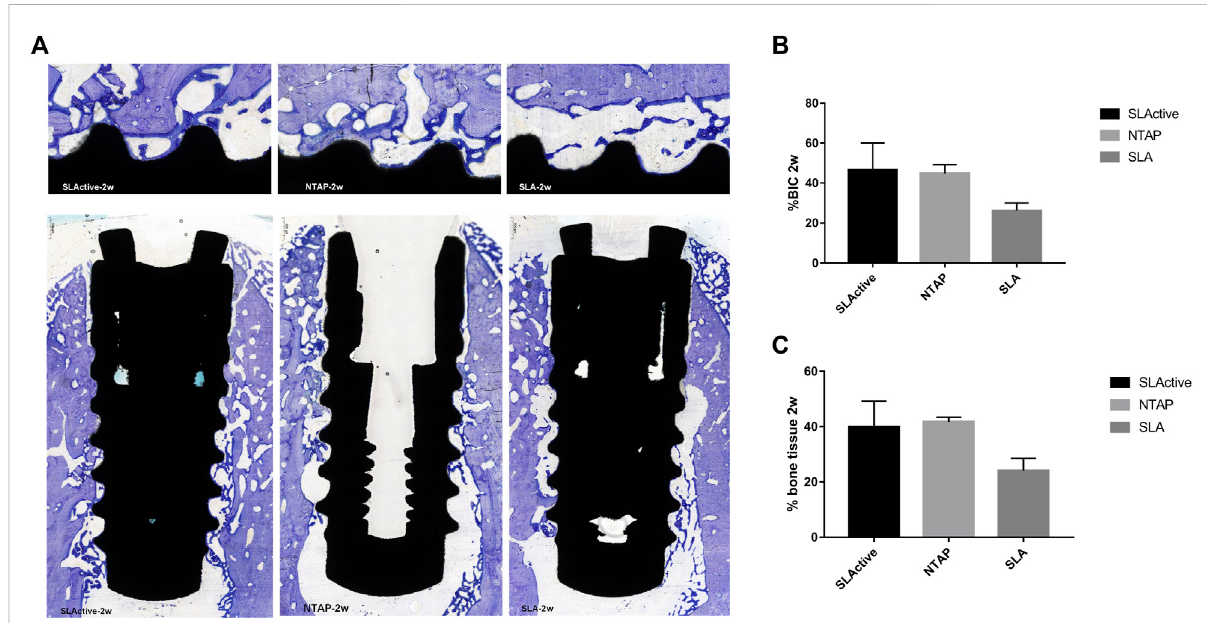
FIGURE 5 Histological section and analysis after 2 weeks of implantation ( n = 3). (A) New bone formation was assessed by toluidine blue staining in the SLActive,NTAP,andSLAgroups.Magni fi cation:upper×10andlower×2andscalebar=500 μ m. (B) PercentageofhistologicalBIC. (C) Percentageof bone tissue in wound chamber. Values represent the means of data obtained from three different experiments with standard deviations. * = p < 0.05 of the Friedman test using IBM SPSS 26 (the error bars indicate standard deviations).